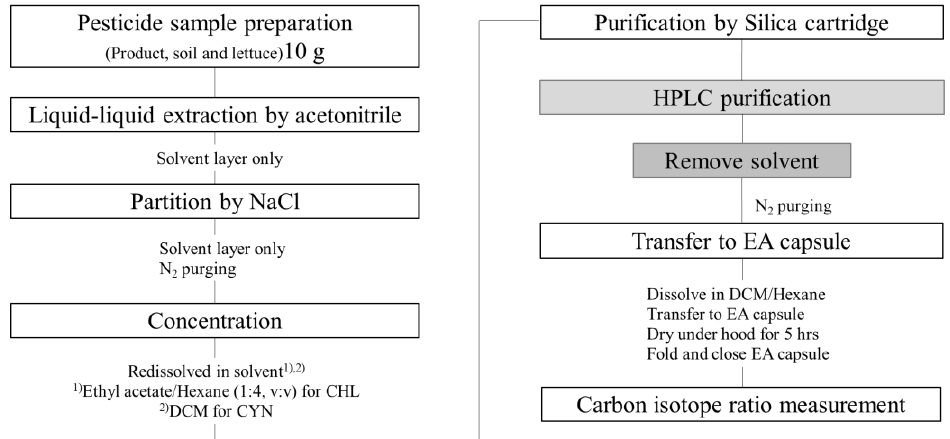
Figure 6. Schematic workflow to determine residual pesticides in samples for environmental and agricultural applications.